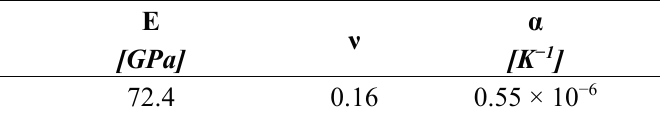
Table 3. Mechanical and thermal properties of